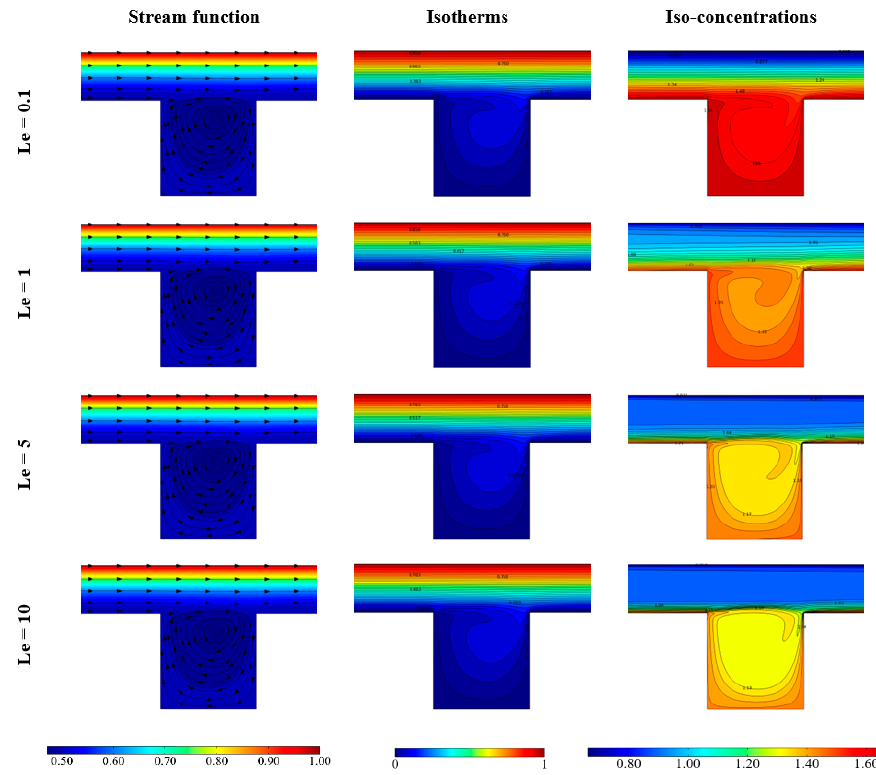
Figure 4. Stream function, Isotherms and Iso-concentration for various Lewis number and Pr = 6.2, Re = 100, N B = N T = 0.1.